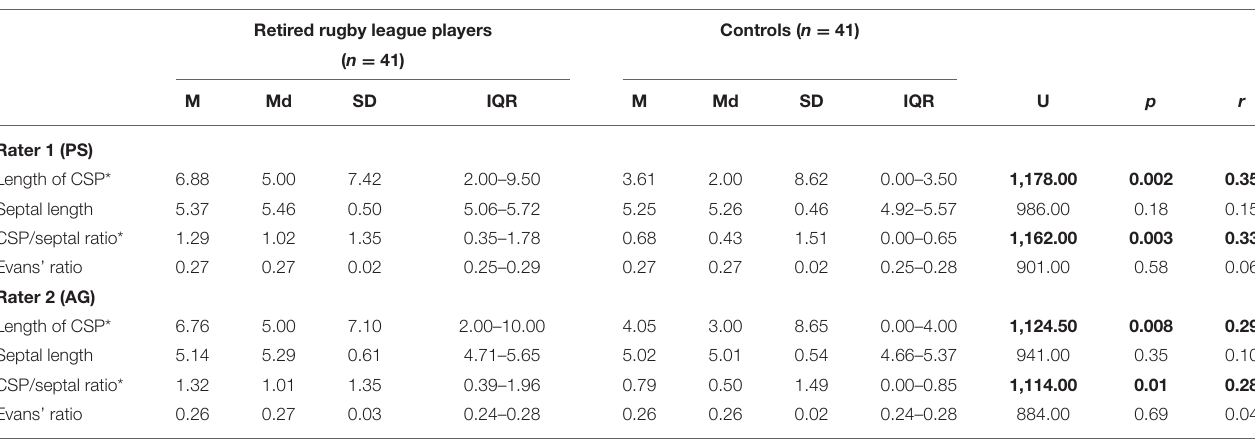
TABLE 1 | Group comparisons on CSP and ventricle